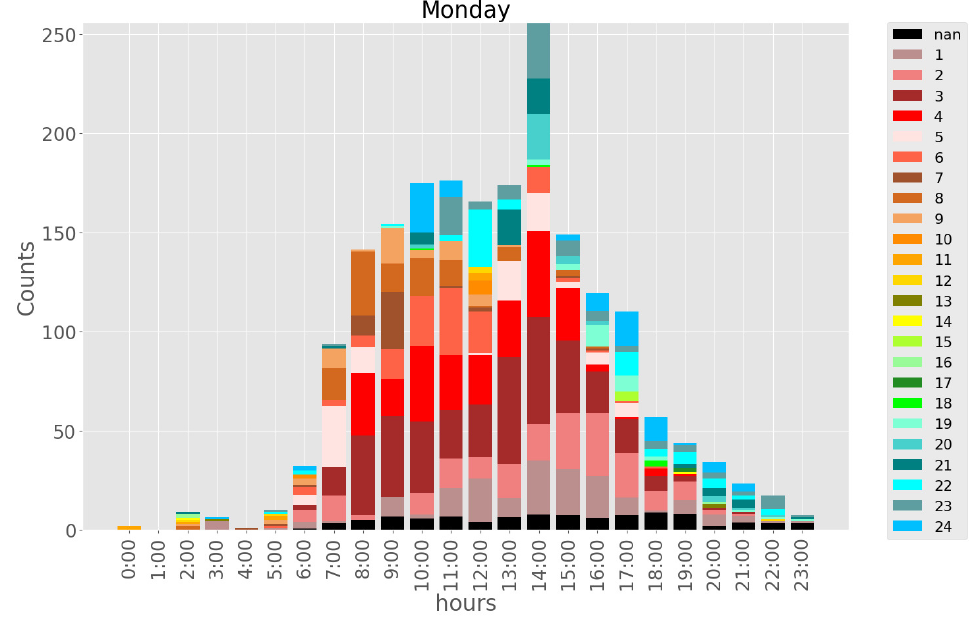
Figure 6. Vehicle stay times from 1 November 2020 to 7 November 2020 at Location